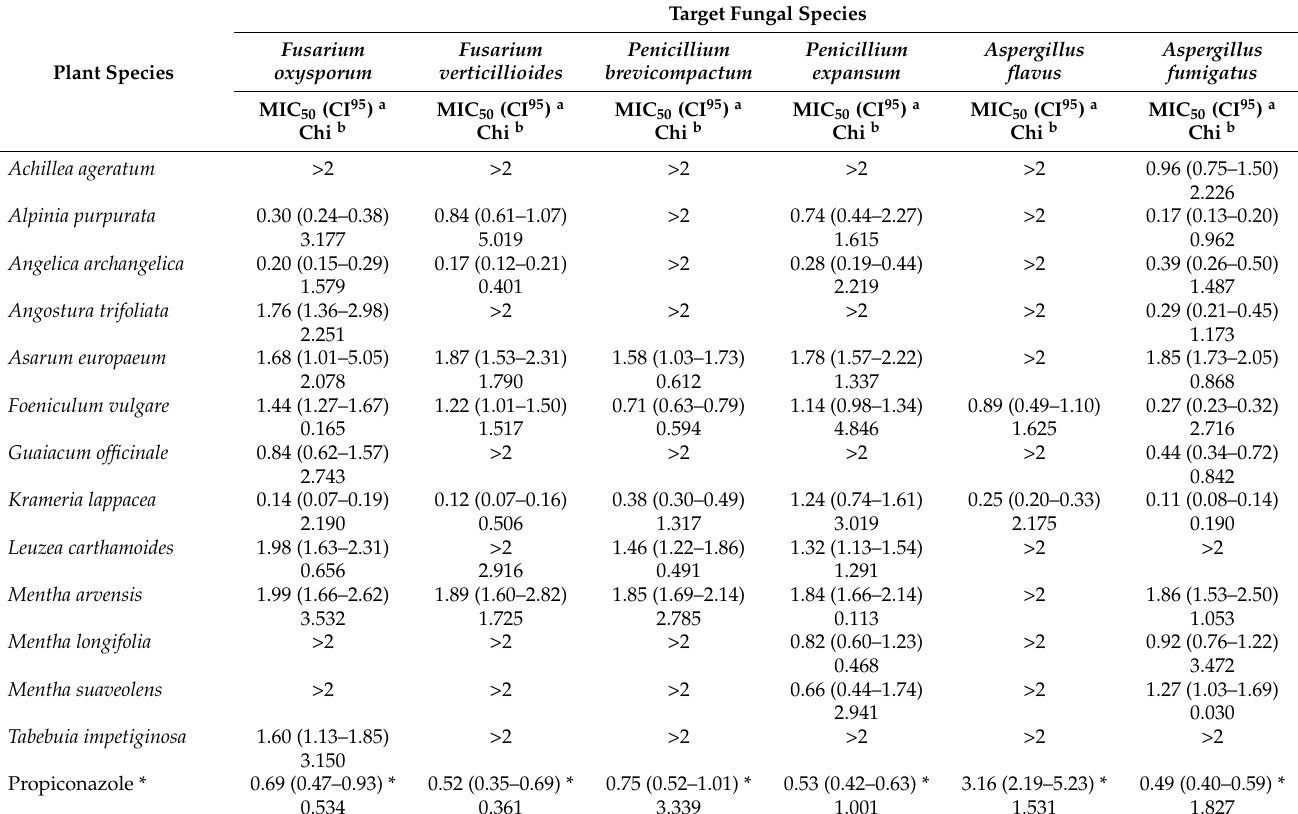
Table 3. Medium inhibitory concentration of the most effective plant extracts against target fungal species (mg mL − 1